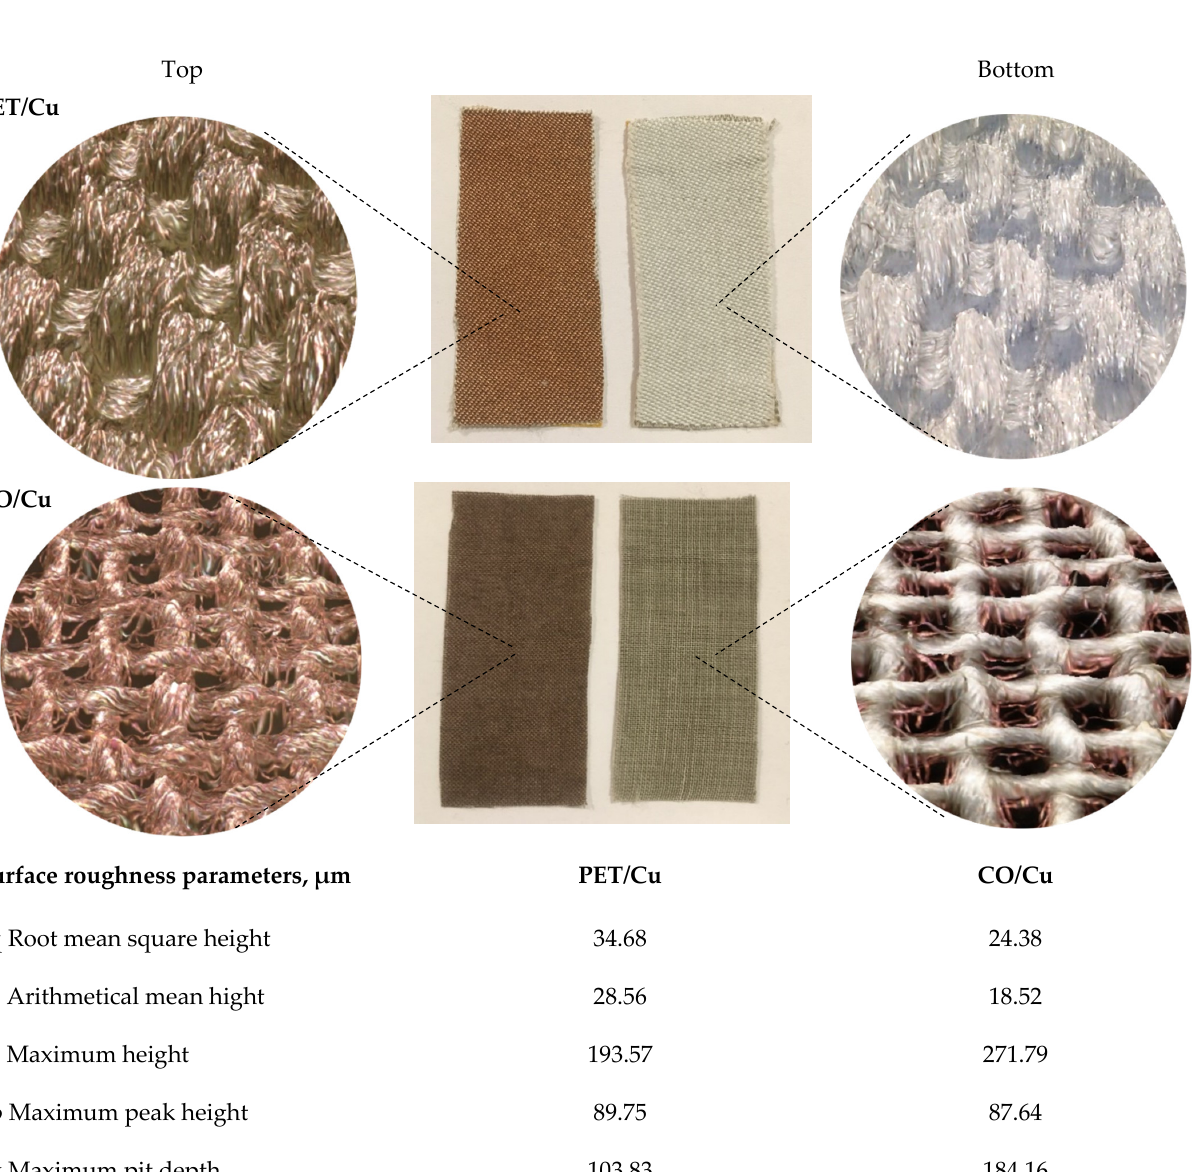
Figure 3. Photos and the microscopic 3D images (magnification × 100) and surface roughness parameters of the Cu modified fabrics.